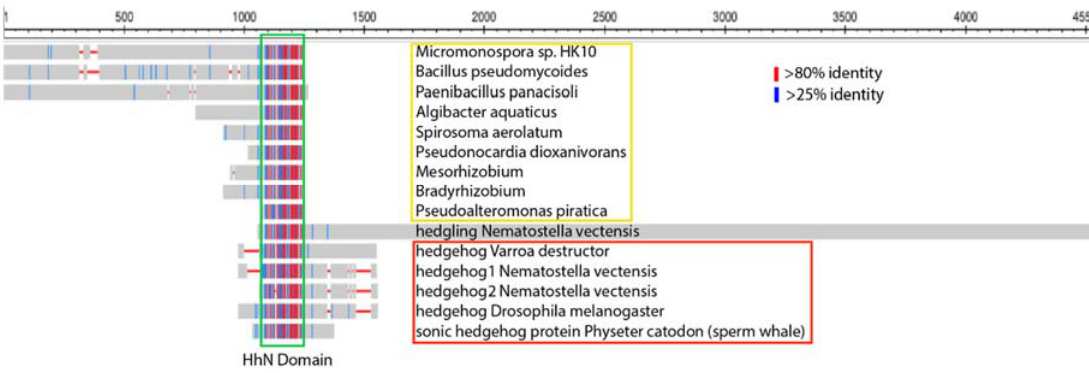
Figure 3. HhN domains are present in bacteria. Lineup of several hypothetical proteins in bacteria, Hedgling and metazoan Hhs. The conserved domain (HhN, green box, about 175 residues) is flanked by other sequences in the various species. In bacteria (yellow box) the HhN domain is the C ‐ terminal end of the hypothetical proteins. The HhN domain is the N ‐ terminal part of Hedgling and Hhs (red box). The blue and red lines indicate medium and high levels of conservation. Accession numbers of the aligned proteins are in the supplementary file.